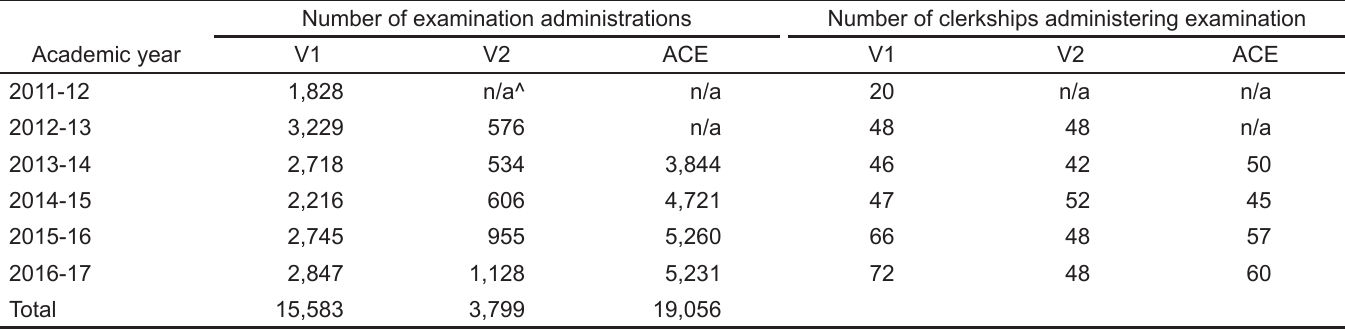
Table. Usage of the National EM M4 examinations (Version 1 and Version 2) and the NBME® EM ACE since implementation.